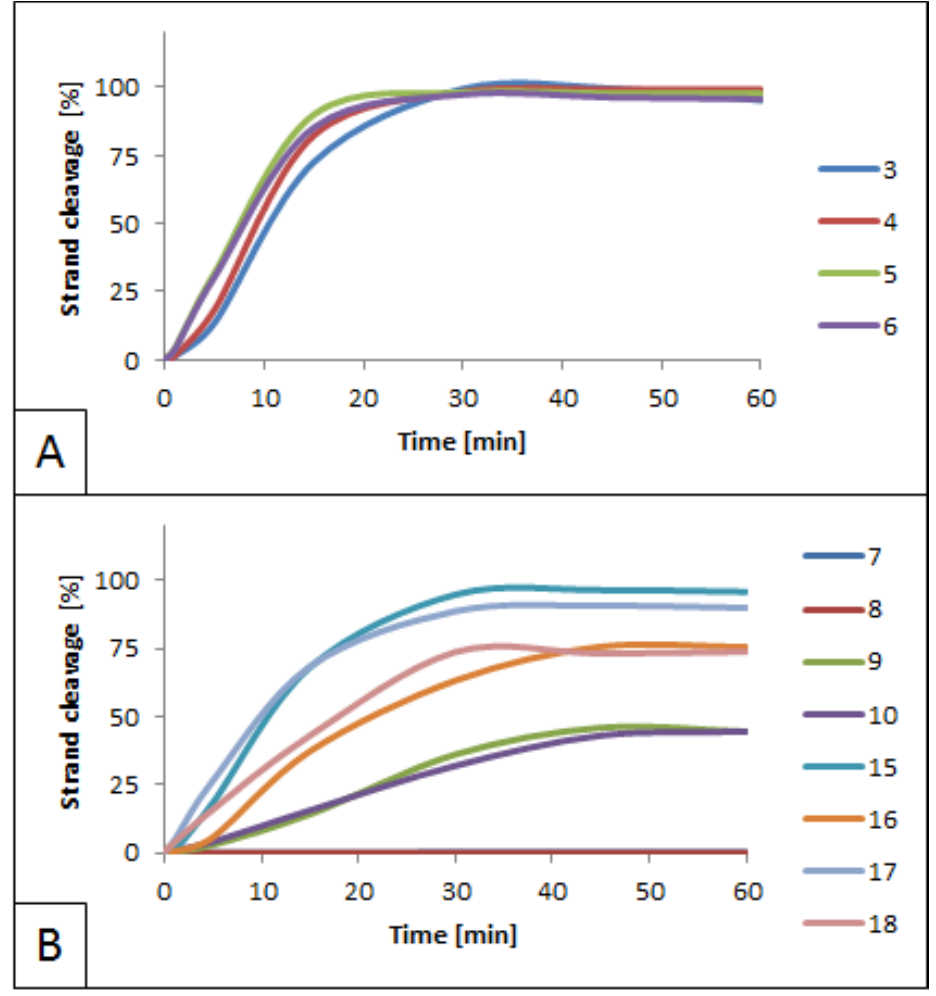
Figure 4. Cleavage of dsDNA containing ScdA and RcdA by 0.5 U BsmAI. ( A ) Quantity increase of cleaved strands 3–6. These strands are arranged in duplexes B and C, which contain cdA lesions located within the recognition site of SspI (Figure 2). ( B ) Quantity increase of cleaved strands 7–18. These strands are arranged in duplexes D–E and H–I, which contain cdA lesions located within the cleavage site of BsmAI (Figure 2).